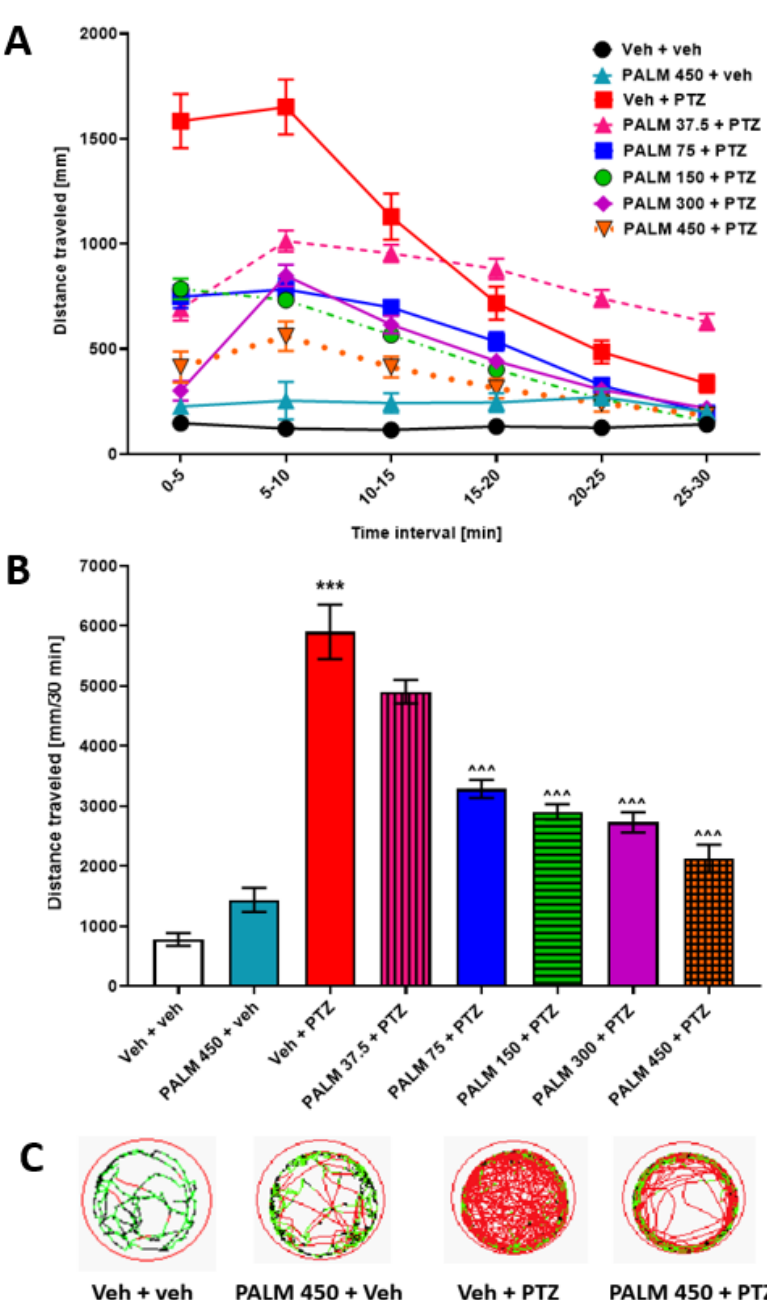
Figure 5. The influence of PALM on the seizure-like behavior in the PTZ-induced zebrafish hyperlocomotion assay. After a 24-h incubation in different doses of PALM (37.5, 75, 150, 300, or 450 µM), 7 dpf zebrafish larvae were exposed to 20 mM PTZ. Seizure-like behavior was assessed 5 min after acute PTZ exposure. Results of the assay are presented as ( A ) distance traveled in 5 min intervals, and ( B ) total distance traveled during 30 min of assay, ( C ) digital tracking map of larvae at second (5–10 min) interval of experiment: large movement—red, small movement—green. Data were analyzed using one-way or two-way with repeated measures ANOVA followed by the Tukey’s or Bonferroni’s post-hoc test, respectively. Data are depicted as a mean ± SEM. Veh + veh ( n = 36), PALM 450 + veh ( n = 26), Veh + PTZ ( n = 34), PALM 37.5 + PTZ ( n = 46), PALM 75 + PTZ ( n = 48), PALM 150 + PTZ ( n = 48), PALM 300 + PTZ ( n = 47), PALM 450 + PTZ ( n = 32). *** p < 0.001 vs. Veh + veh; ˆˆˆ p < 0.001 vs. Veh + PTZ. PALM—palmatine, PTZ—pentylenetetrazole,